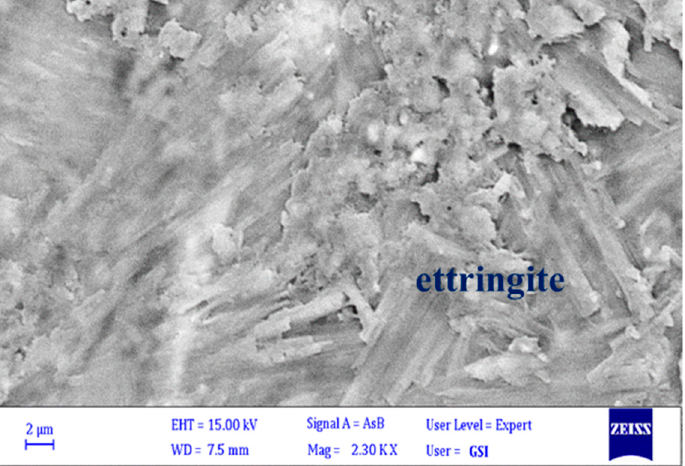
Figure 10. SEM micrographs of ettringite in the Bathurst limestone concrete prism samples after 6 months.